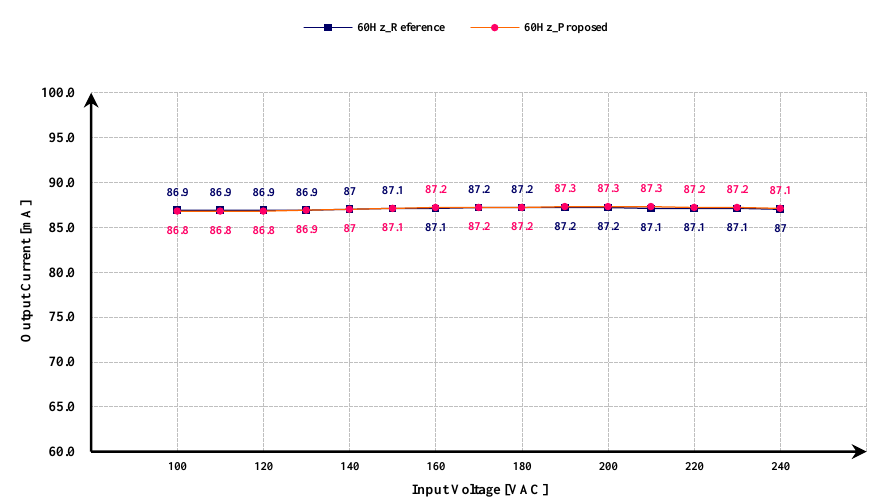
Figure 9. Output current according to the input voltage.